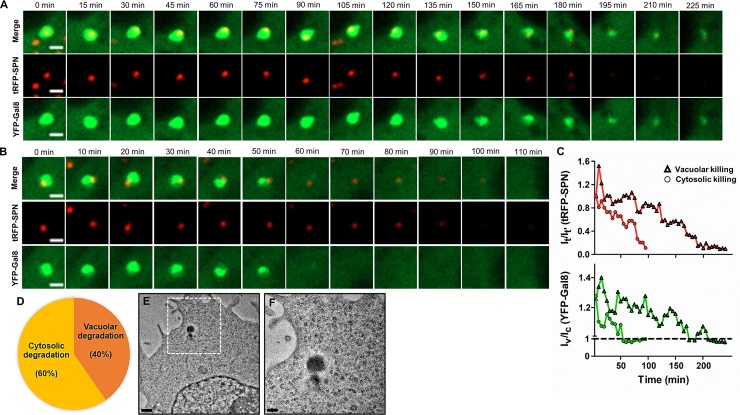
Delay in SPN containing autophagosomal maturation and escape into cytosol.A & B. Representative time-lapse montage for degradation of SPN inside Gal8 marked autophagosomes (A) or in cytosol (B). hBMECs stably expressing YFP-Gal8 (green) were infected with WT SPN constitutively expressing tRFP (red) and live imaging of infected cells was performed for extended hours beginning at 3 h p.i. under a confocal microscope. Time-lapse series with intervals of 15 min (A) or 10 min (B) are represented. The stills in “A” and “B” correspond to movies shown as S1 and S2 Movies, respectively. Scale bar, 2 μm. C. Comparison of temporal quantification of fluorescence intensities of Gal8 (lower graph) and SPN (upper graph) in “A” and “B” relative to either cytosol (Iv/Ic for Gal8, where Iv and Ic are fluorescence intensities in vacuole and cytosol, respectively) or SPN fluorescence at 0 min (It/It' for SPN, where It and It' are fluorescence intensities of the Gal8 marked SPN at a given time point or 0 min, respectively). D. Percentage of intracellular SPN undergone vacuolar or cytosolic degradation as examined by time-lapse imaging of hBMECs stably expressing YFP-Gal8 following infection with tRFP expressing SPN. n = 57. E & F. Transmission electron micrograph depicting presence of WT SPN in cytosol without any membrane limiting structures (E). Scale bar, 0.5 μm. Zoomed in view of the boxed area in “E” is shown in “F”. Scale bar, 0.2 μm.